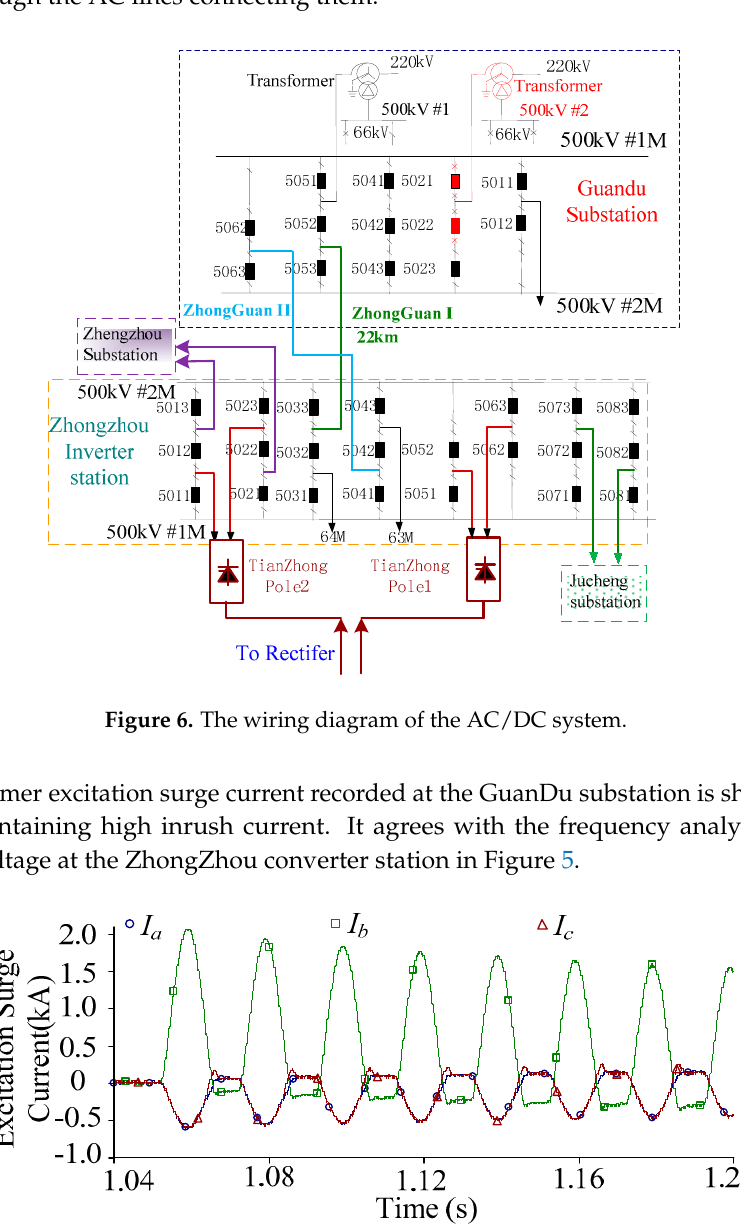
Figure 7. The transformer excitation surge current recorded at the GuanDu substation.